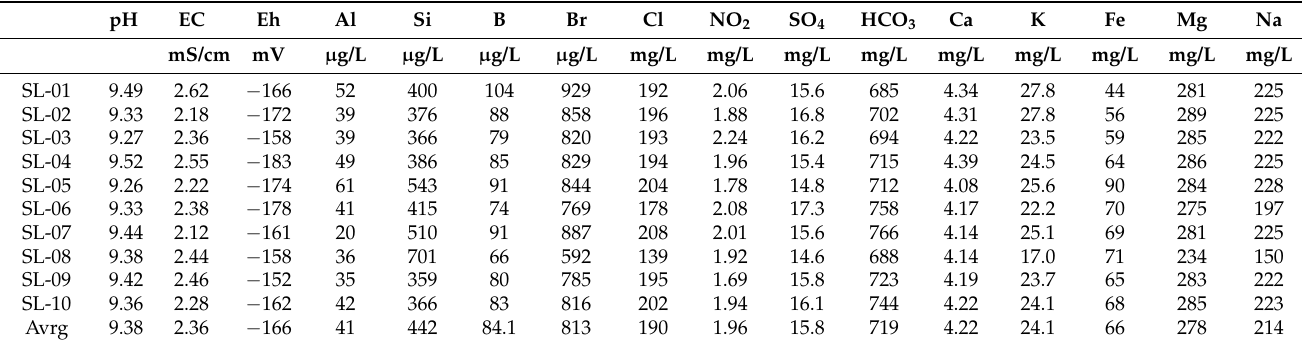
Table 1. Anion and cation analysis results of lake water in